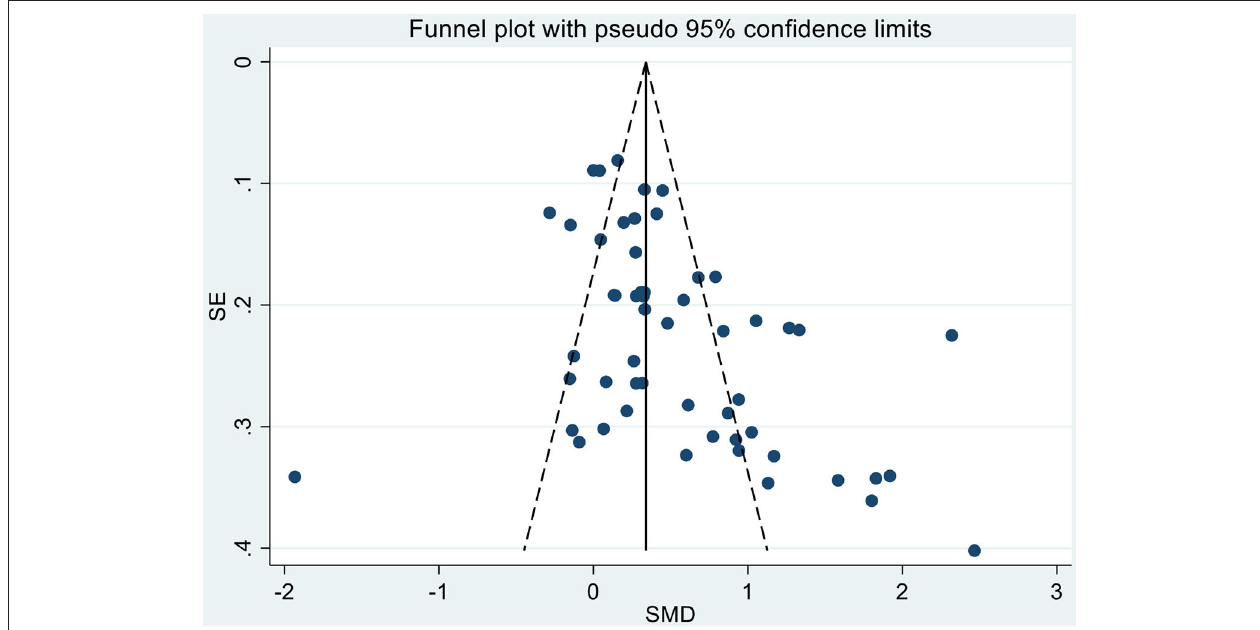
FIGURE 3 | Funnel plot for standardized mean differences (SMDs) of subjective well-being (SWB) and standard errors (SEs) for 31